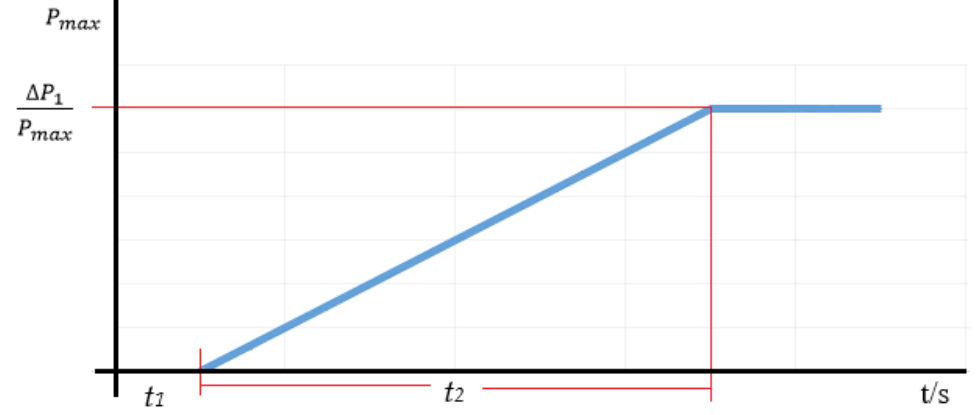
Figure 1. Active power frequency response capability [6].